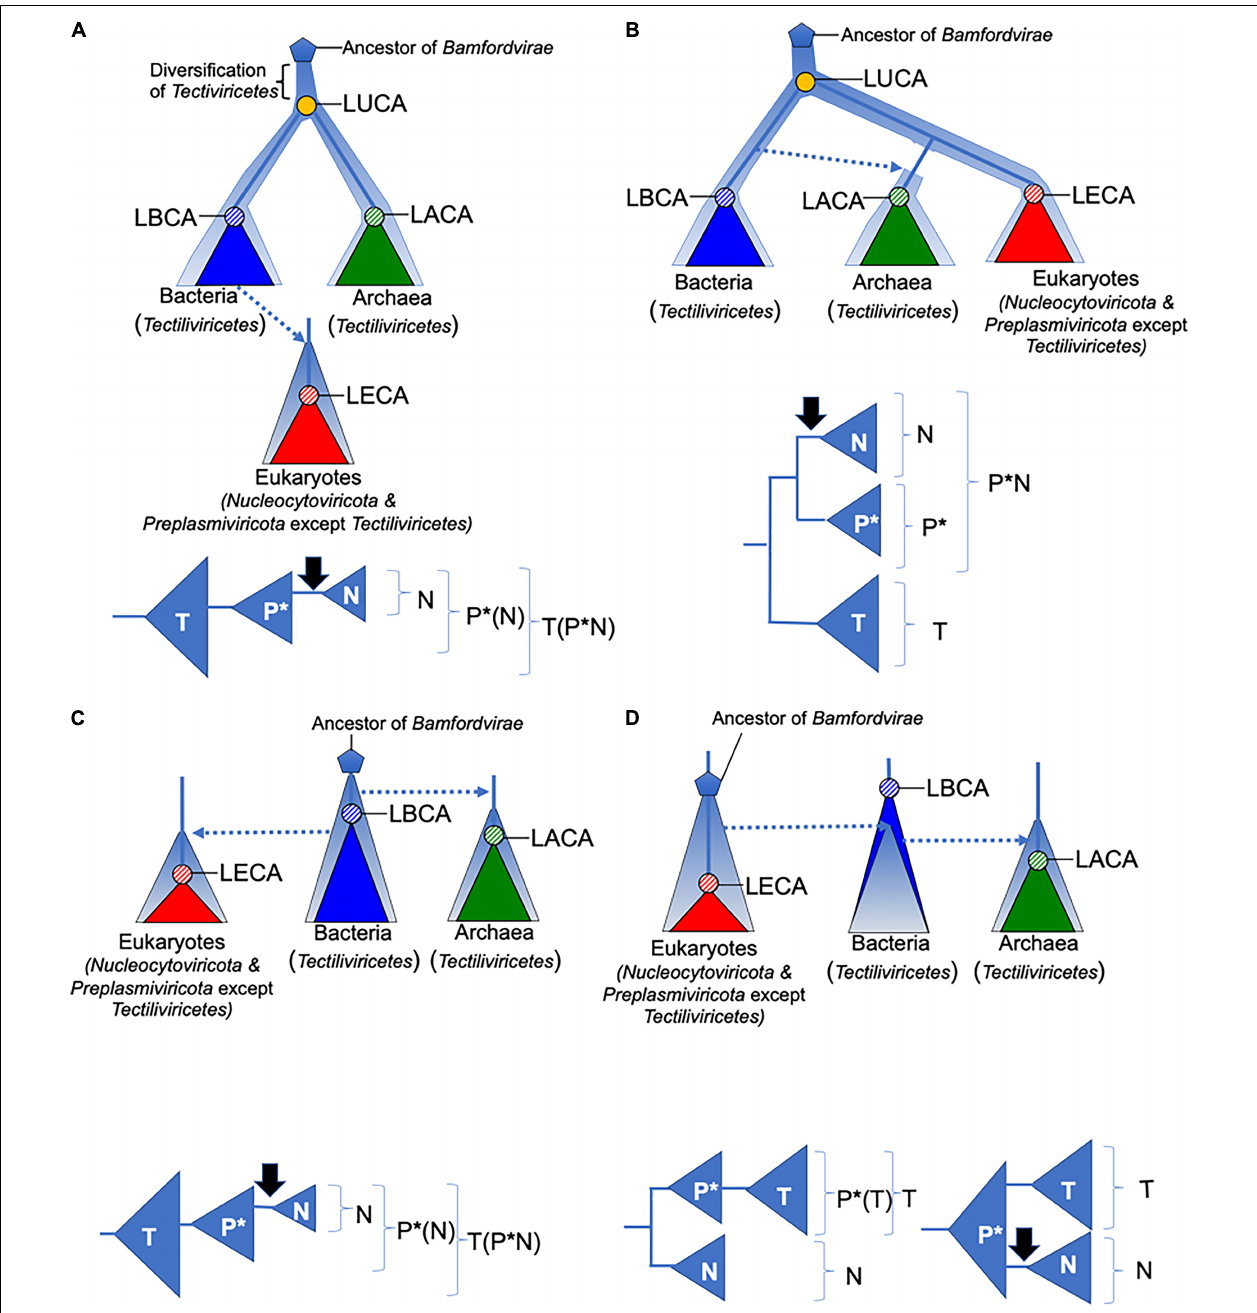
FIGURE 2 | Four scenarios for the evolution of Bamfordvirae . The diversification and evolution of viruses are depicted with pale blue thick lines or triangles. Lower panels depict groups that are monophyletic (in brackets) among Tectiliviricetes (T), Preplasmiviricota except Tectiliviricetes (P*), and Nucleocytoviricota (N) in the above scenarios. The black arrows indicate the introduction of DNA replication proteins related to those of Duplodnaviria in the ancestral lineage of Nucleocytoviricota . Dotted arrows indicate transfer of viruses between different cellular domains. In all scenarios, we assumed that Bamfordvirae were present in the last archaeal common ancestor (LACA). In panels (A,B) , the origin of Bamfordvirae (blue pentagon) predated the last universal common ancestor (LUCA). In panel (A) , Tectiliviricetes emerged first and different lineages were selected and co-evolved with the proto-bacterial and proto-archaeal lineages. In panel (B) , the ancestral Varidnaviria thriving at the time of LUCA have now disappeared, Tectiliviricetes emerged in the bacterial branch and were later transferred to Archaea. The ancestors of eukaryotic Bamfordvirae were lost in Archaea. In panels (C,D) , Bamfordvirae originated after LUCA, either in proto-bacteria (C) or proto-eukaryotes (D) . They appeared later in the two other domains by virus transfer. LUCA, last universal common ancestor; LACA, last archaeal common ancestor; LBCA, last bacterial common ancestor; LECA, last eukaryal common ancestor.